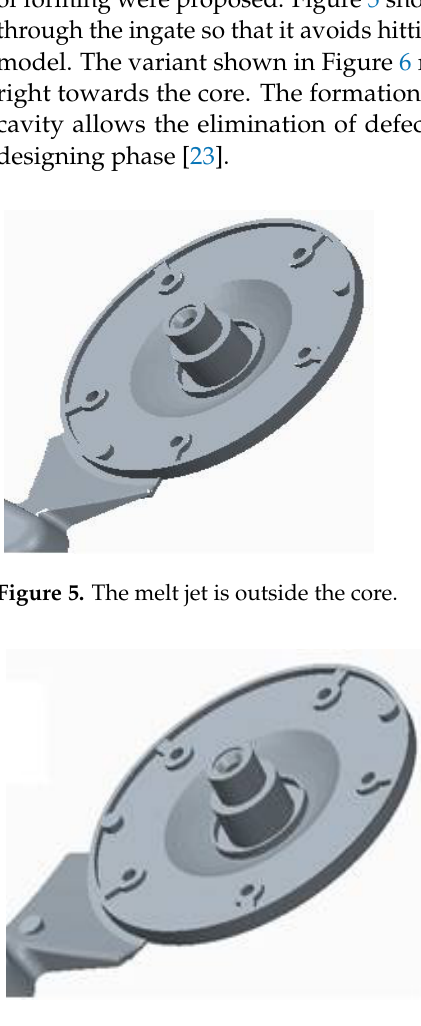
Figure 4. 3D model of designed gating system. Table 5. Dimension of the gating system.